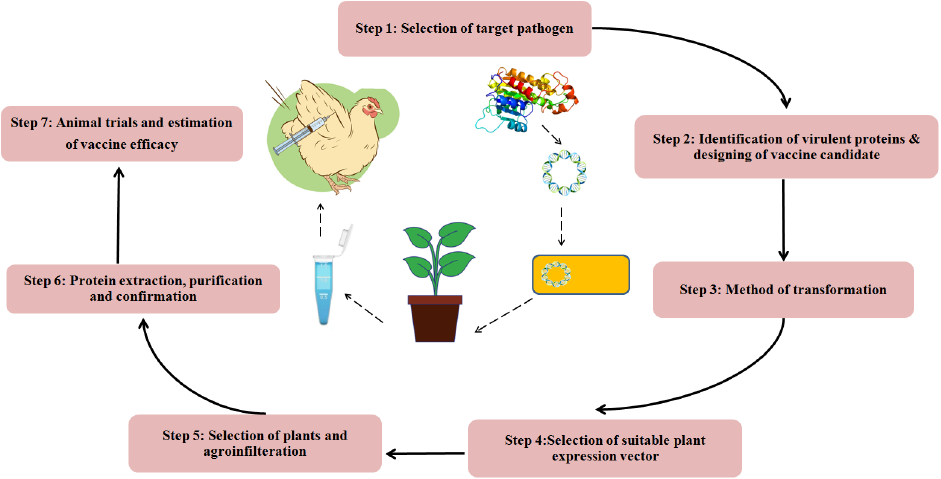
Figure 4. Steps involved in the production of plant-based